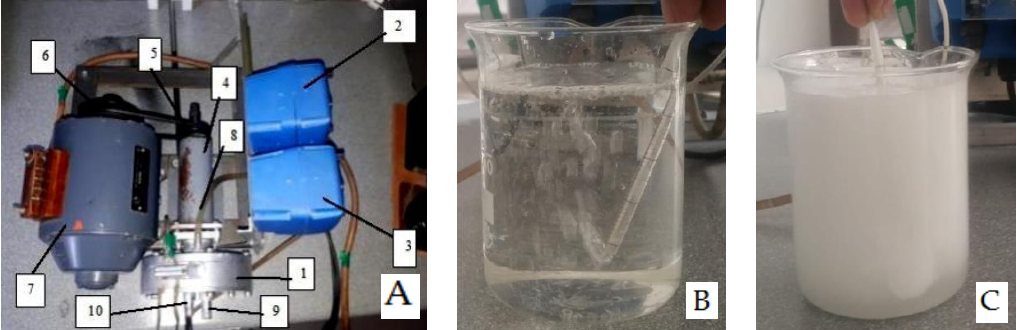
Figure 4. ( A ) Water-air microemulsion generator. ( B ) Image of frother solution before dispersion. ( C ) Image of frothersolution after dispersion in the generator. ( A ) WAME generator: 1 —